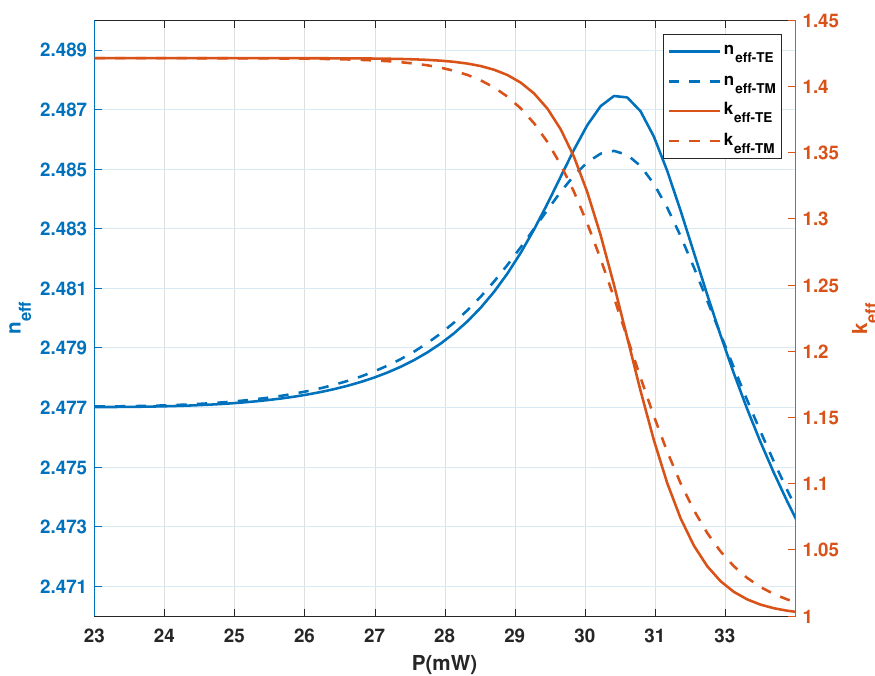
Figure 8. The complex effective index of graphene on USRN waveguide versus the injected optical pump power. The graphene layer is made of a layer of a 8 nm sheet. The real part of the effective index is n ef f (blue curve, left y-axis) and the imaginary part (loss coefficient) is k ef f (red curve, right y-axis). This simulation study enabled the determination of an optimal power tuning range of 28–33 mW.